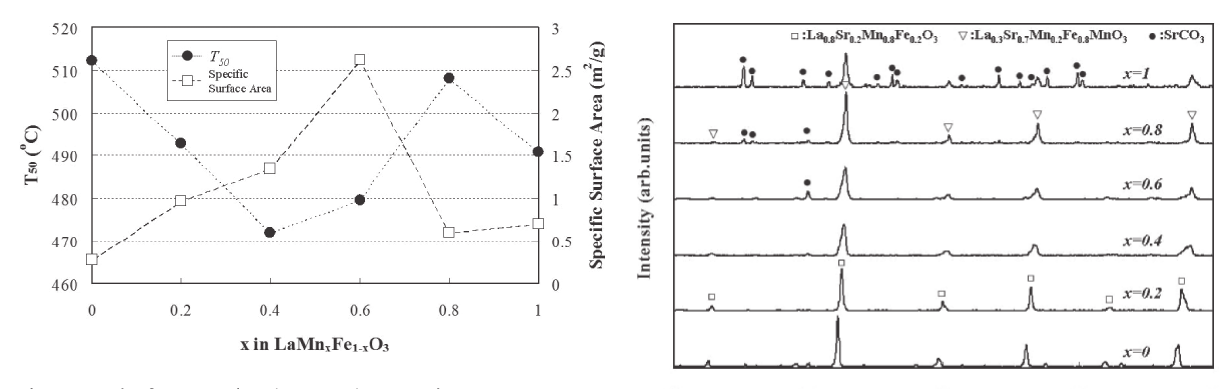
Fig. 2: Result of soot combustion experiment and BET measurement of prepared LaFe Mn O . X axis shows the amount of Mn in 1 − x x 3 LaFe Mn O and Y axis shows T ; the temperature at which 50% of 1 − x x 3 50 the soot has been oxidized ( ● ), and specific surface area ( □ ). Fig. 3: XRD patterns of synthesized La